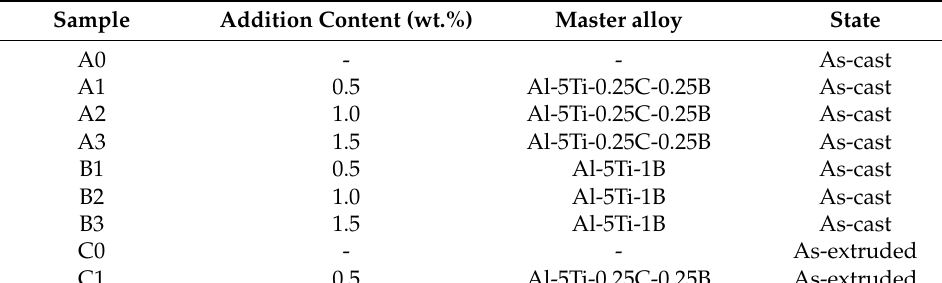
Table 2. Summary of the text alloys with different master alloy addition.